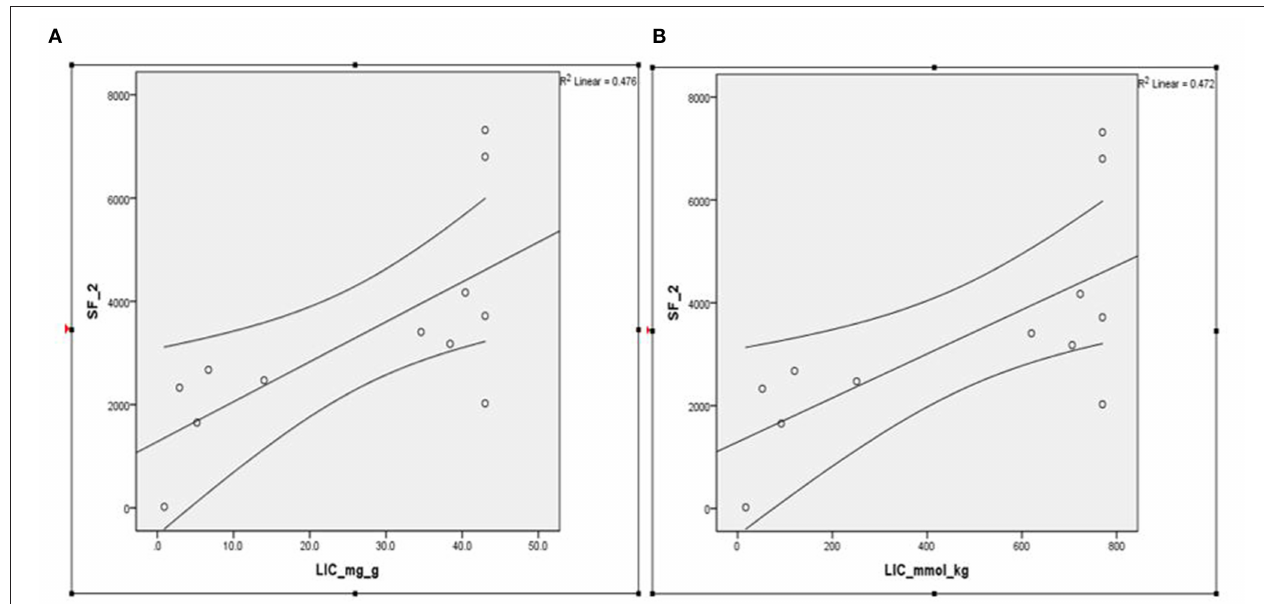
FIGURE 1 | (A,B) Spearmen’s correlation between SF and LIC R2 by FerriScan © as either (A) mg/kg or (B) mmol/kg dry tissue showing that LIC by R2 MRI (FerriScan © ) improves with decreasing SF concentrations (Spearmen’s rho = − 0.723, p < 0.008). SF, serum ferritin; LIC, liver iron concentration.